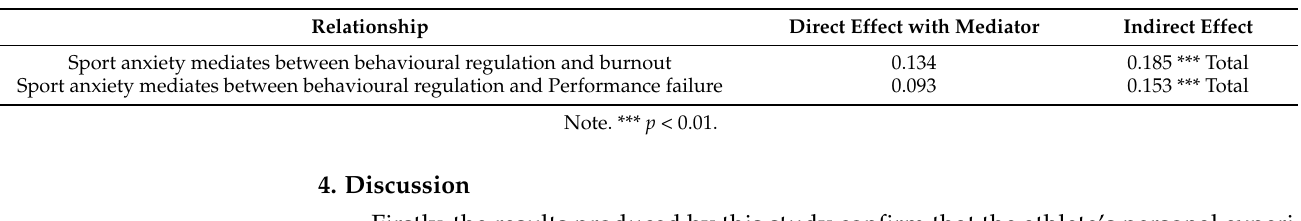
Table 7. Mediation role of Sport